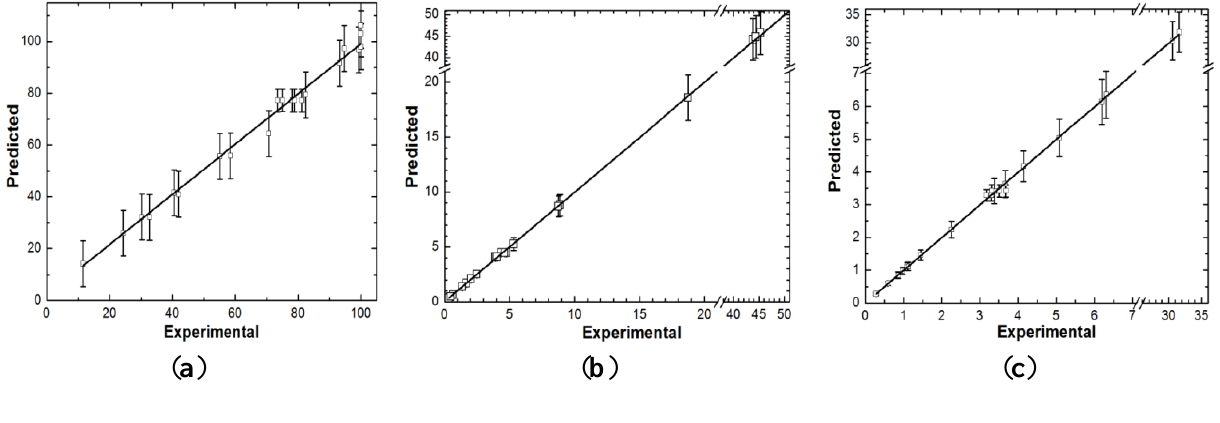
Figure 9. Statistical validation of the models for ( a ) Y ; ( b ) UED ; ( c ) UEMD